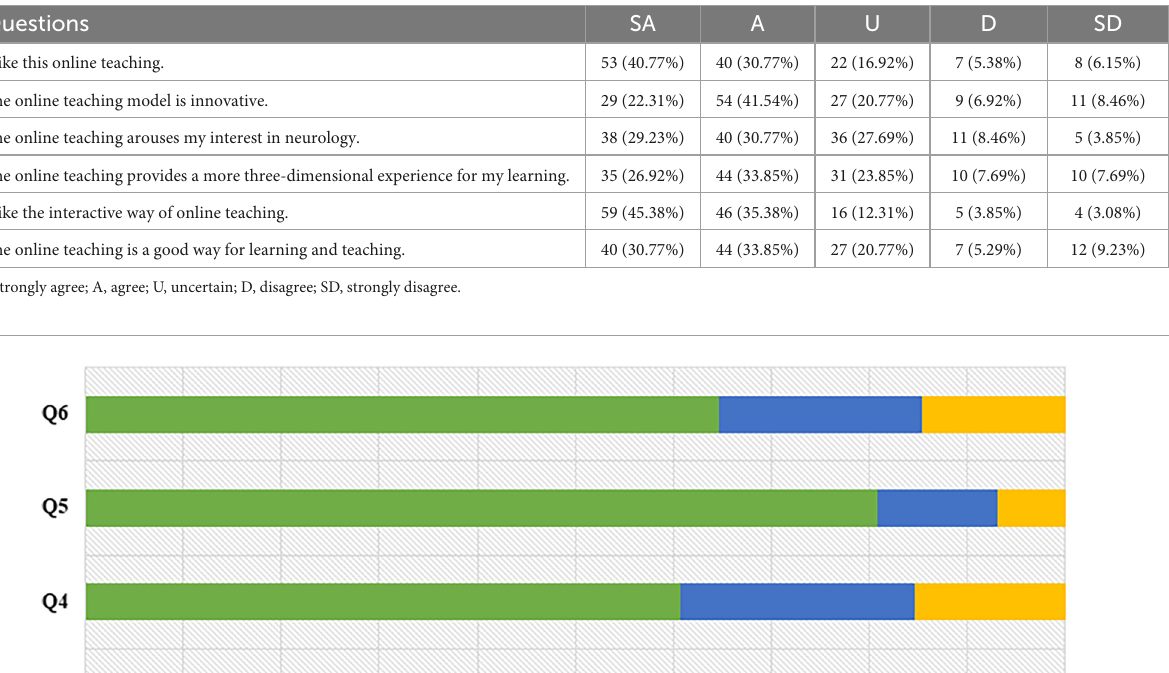
TABLE 2 Students’ attitudes toward this novel online teaching mode.